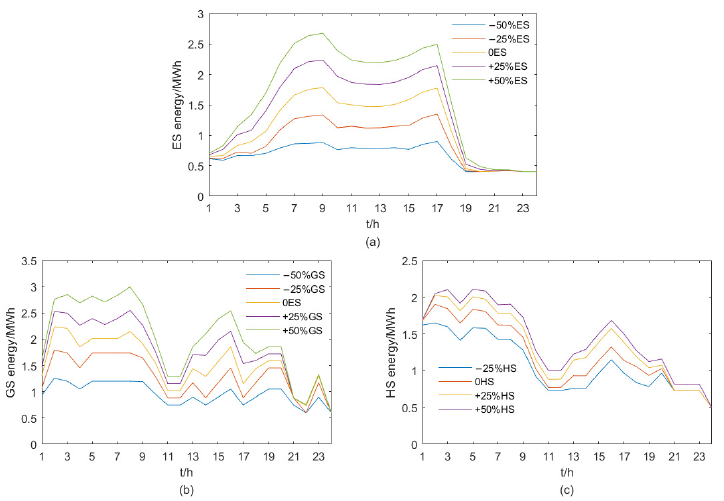
Figure 6. ( a ) ES, ( b ) GS and ( c ) HS operation strategy